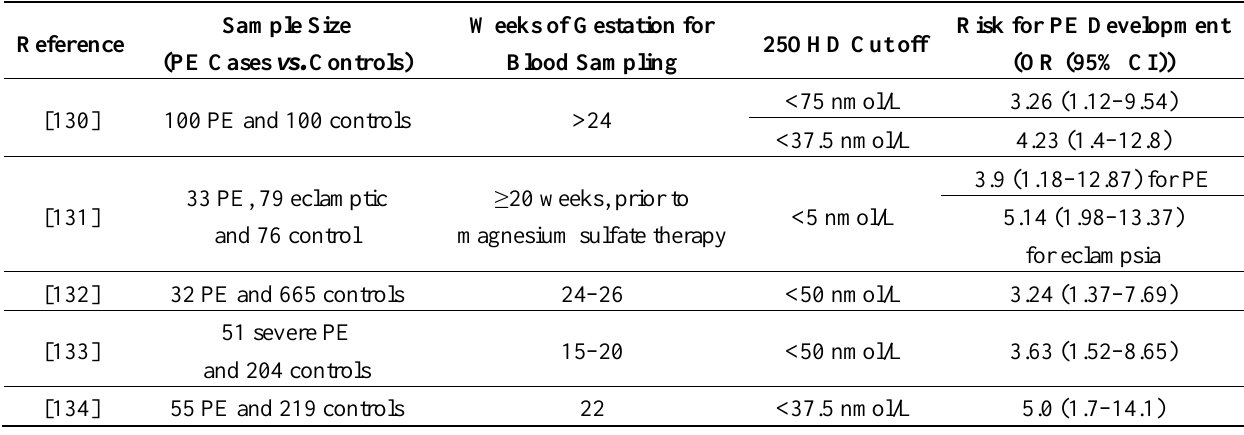
Table 3. Observational studies on 25OHD serum levels and the risk for PE